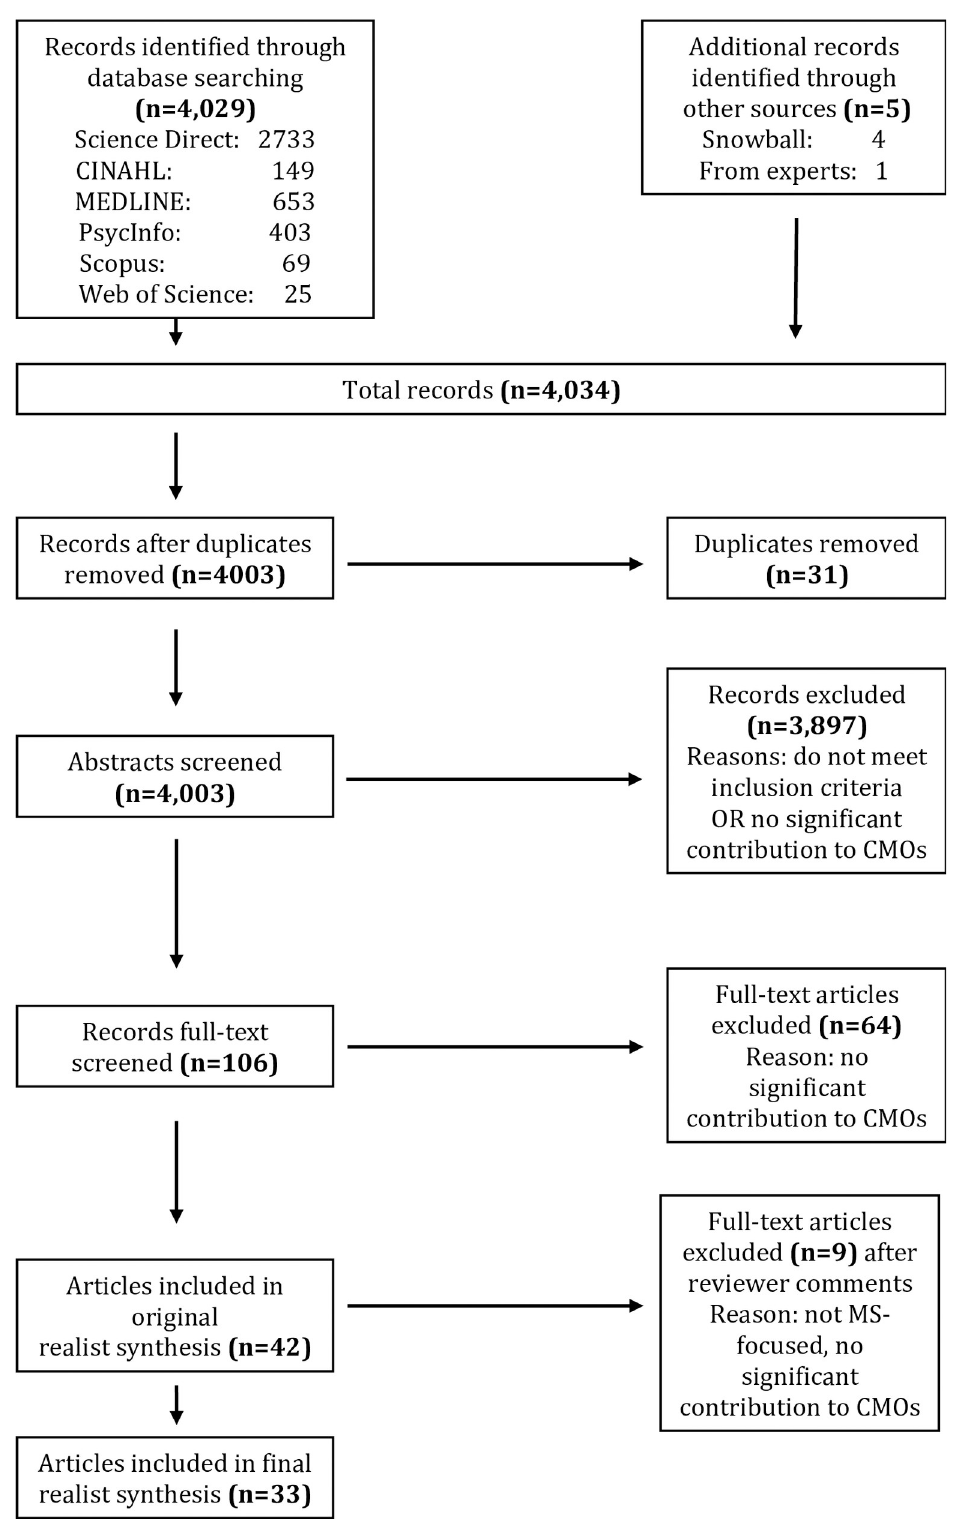
Fig 1. Modified PRISMA flow chart of literature